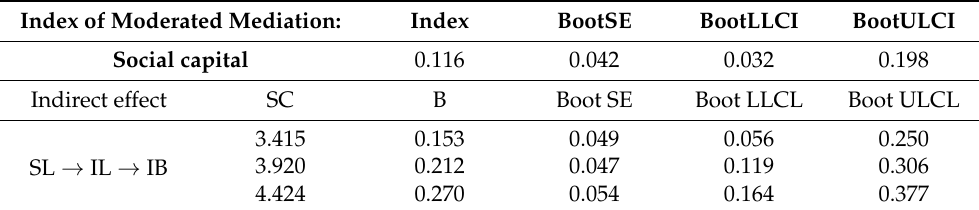
Table 7. Conditional indirect effects of social capital.